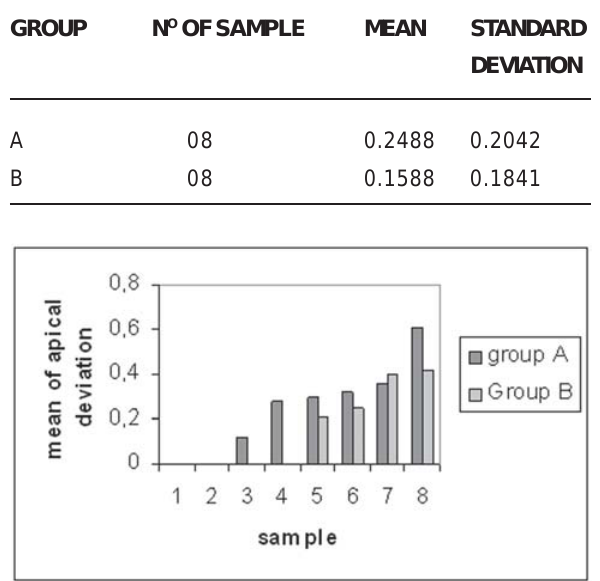
FIGURE 4- Comparison of apical deviation between group A and group